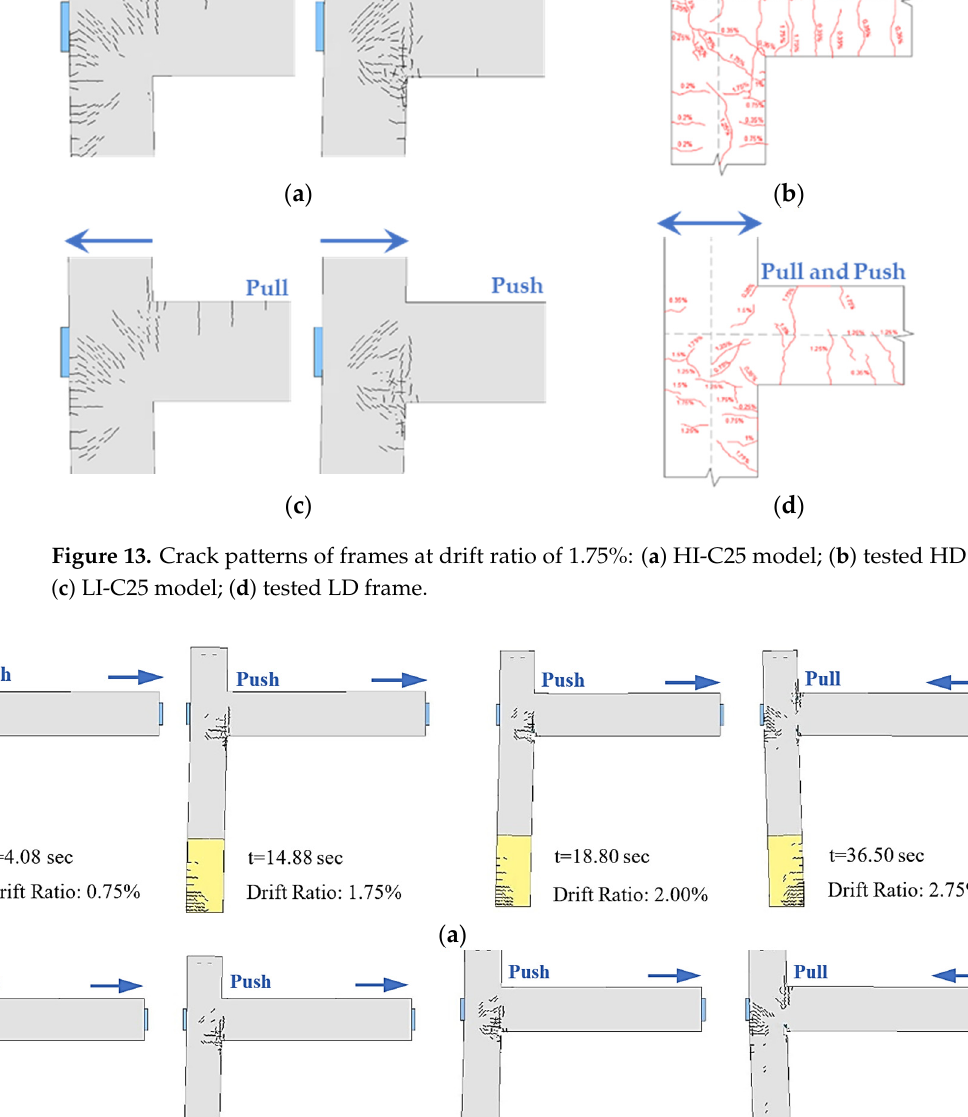
Figure 14. Crack patterns of the frames at varying drift ratios: ( a ) HI-C25 model; ( b ) LI-C25 model. The overall crack patterns of the HD and LD frames were also plotted, as displayed in Figure 14. The crack patterns were captured from the models at varying drift ratios under consequent pull and push forces. The results indicate that the extensive cracks and member erosion (elimination) occurred around the lower and upper column–beam